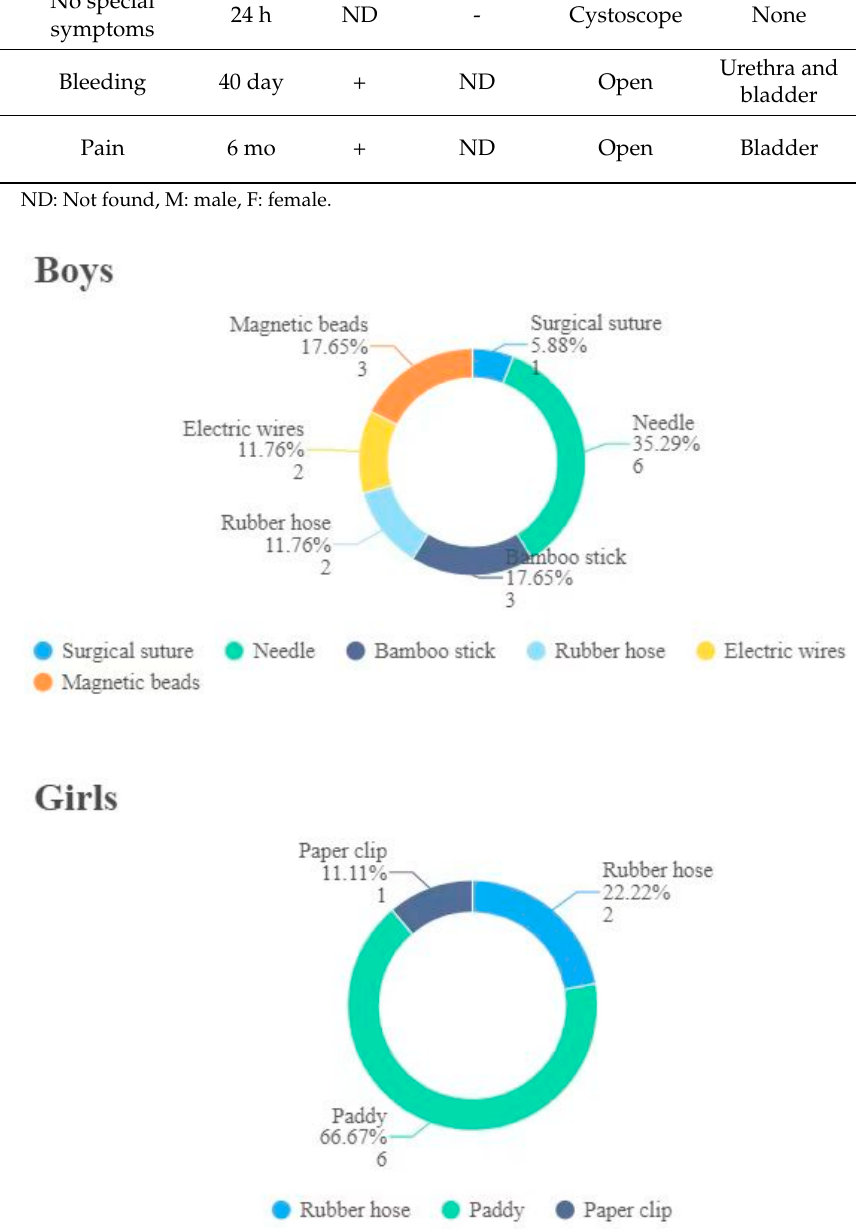
Figure 4. Age distribution of urethral foreign bodies in children.